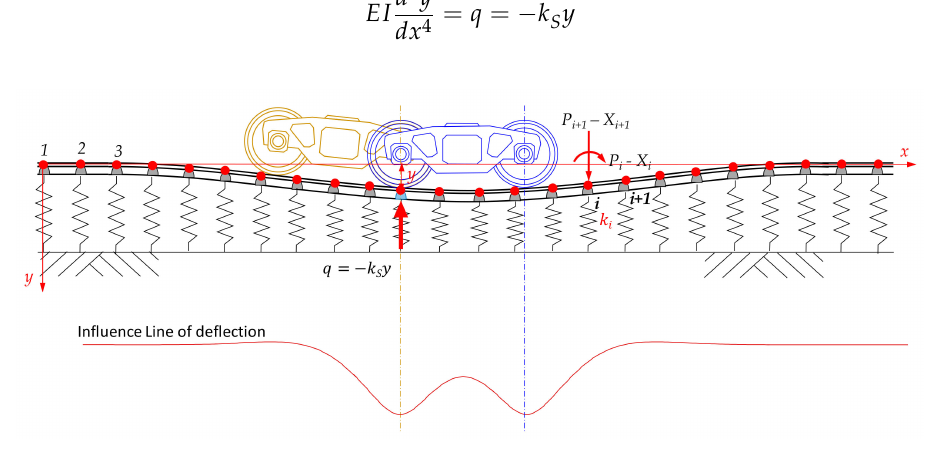
Figure 2. Influence line at a sleeper during train